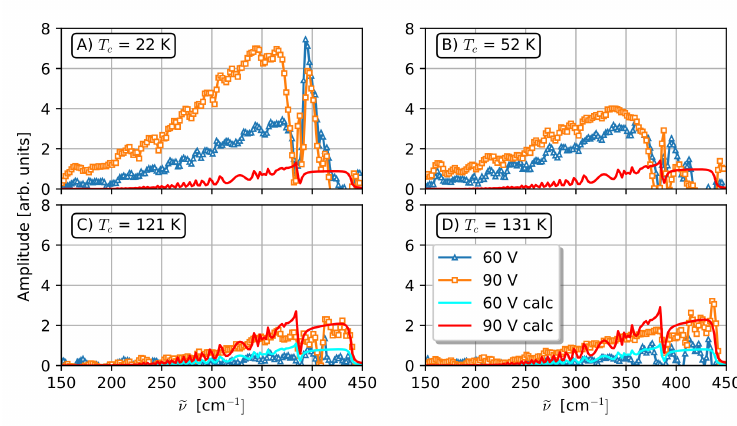
Figure 3. Symbols denote Fourier transform terahertz emission spectra at cryostat itemperatures of 22 K, 52 K, 121 K, and 131 K (panels ( A – D ), respectively) for pulse bias voltages of 60 V and 90 V. Solid curves denote the calculated thermal sample emission for cryostat base temperatures and bias voltages mentioned